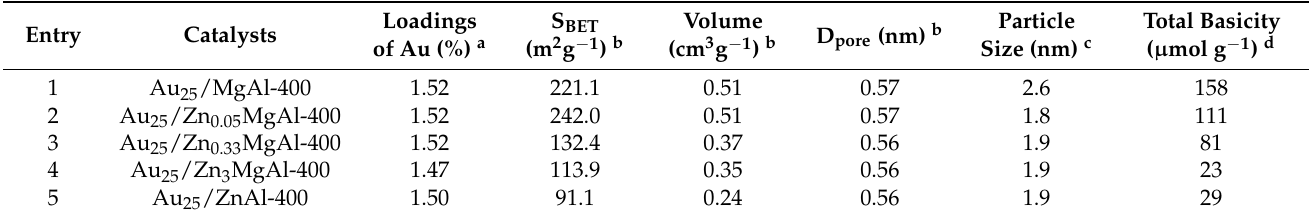
Table 1. Textural properties of Zn-Mg-Al mixed oxides-supported gold catalysts.